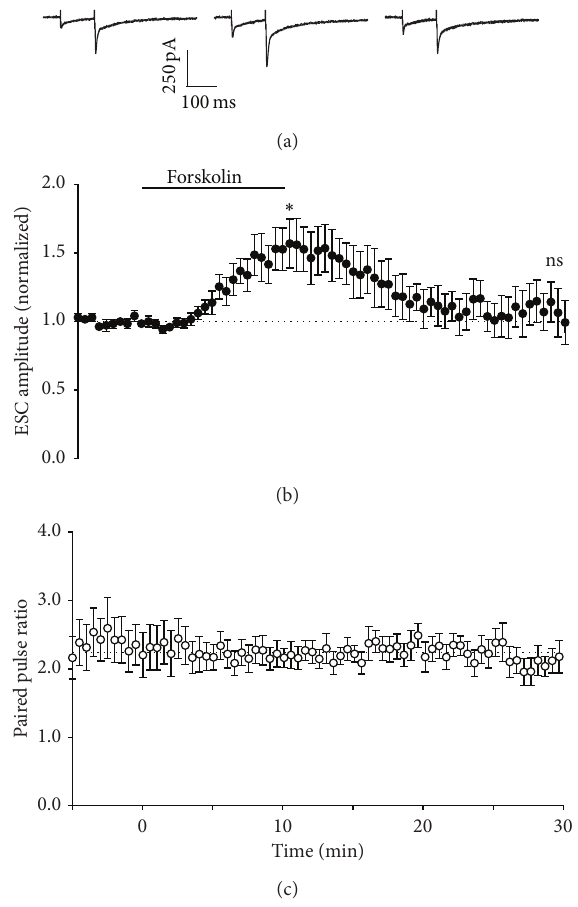
Figure 5: Effect of activation of adenylyl cyclase on Bergmann glial responses. (a) Representative whole-cell recordings of ESCs generated by paired pulse stimulation (100ms interval) of parallel fibres in transverse cerebellar slices at 0.033 Hz before (first panel), after 10 minutes incubation with 50 𝜇 M forskolin (second panel), and after 20 minutes of washout (third panel). (b) Time course of 50 𝜇 M forskolin effect on amplitude of the first pulse in each pair, with forskolin incubation at the time indicated by the bar. Data are mean ± s.e.m. from 7 cells. ∗ 𝑃 = 0.0162 , one-sample 𝑡 -test. (c) Time course of 50 𝜇 M forskolin effect on paired pulse ratio, with forskolin incubation at the time indicated by the bar. Data are mean ± s.e.m. from 7